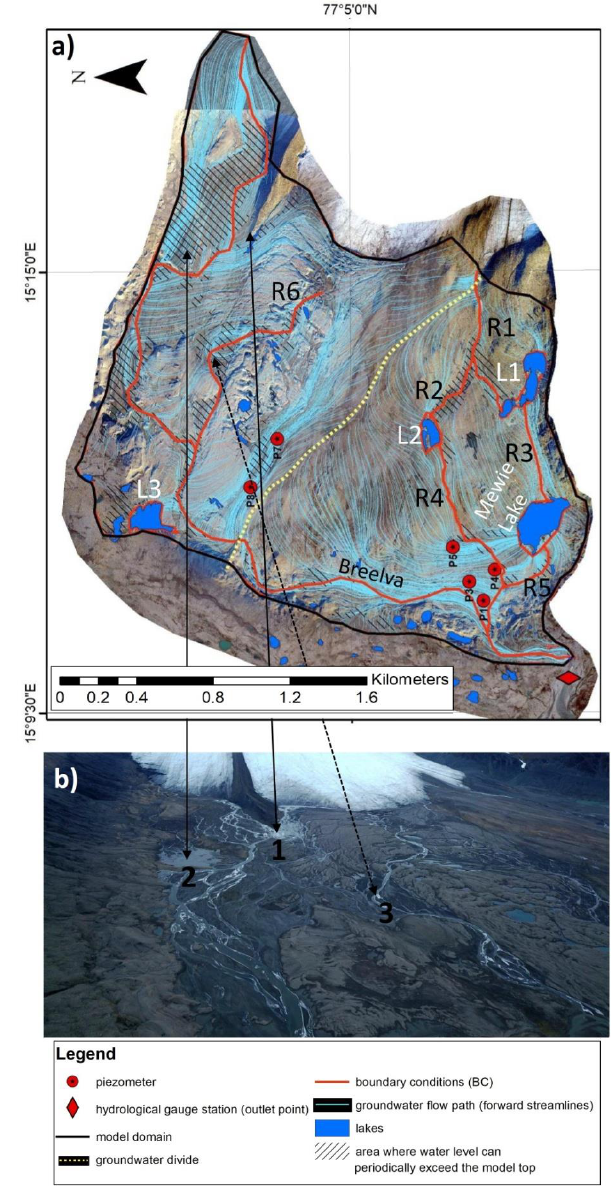
Figure 5. Groundwater flow directions and surface water network in the study area: ( a ) groundwater flow directions modelled with the visible watershed, separating the two subsystems of shallow groundwater circulation (based on an orthophotomap from 2017 and supplemented with data from 2011 prepared by L. Kolondra [66]); white letters L — lakes; black letters R — rivers; ( b ) part of an orthophotomap in 3D view showing streamlines and periodically flooded areas during the ablation season.